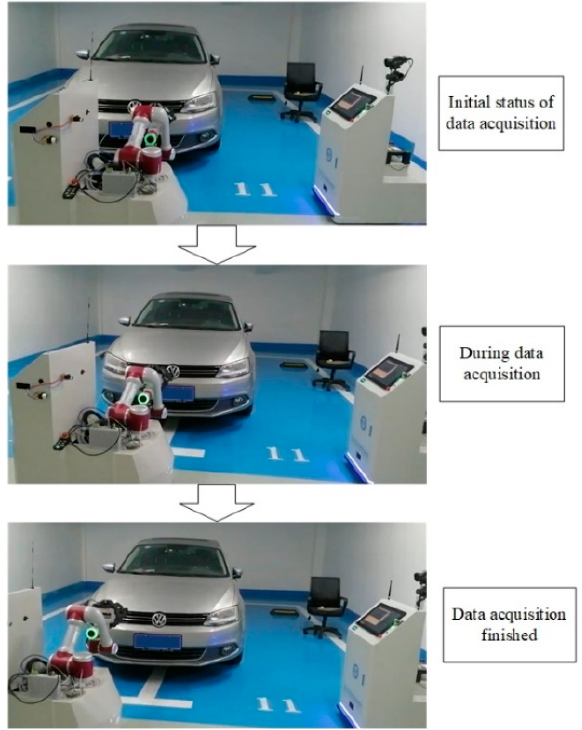
Figure 19. Collaborative measurement data collection process.